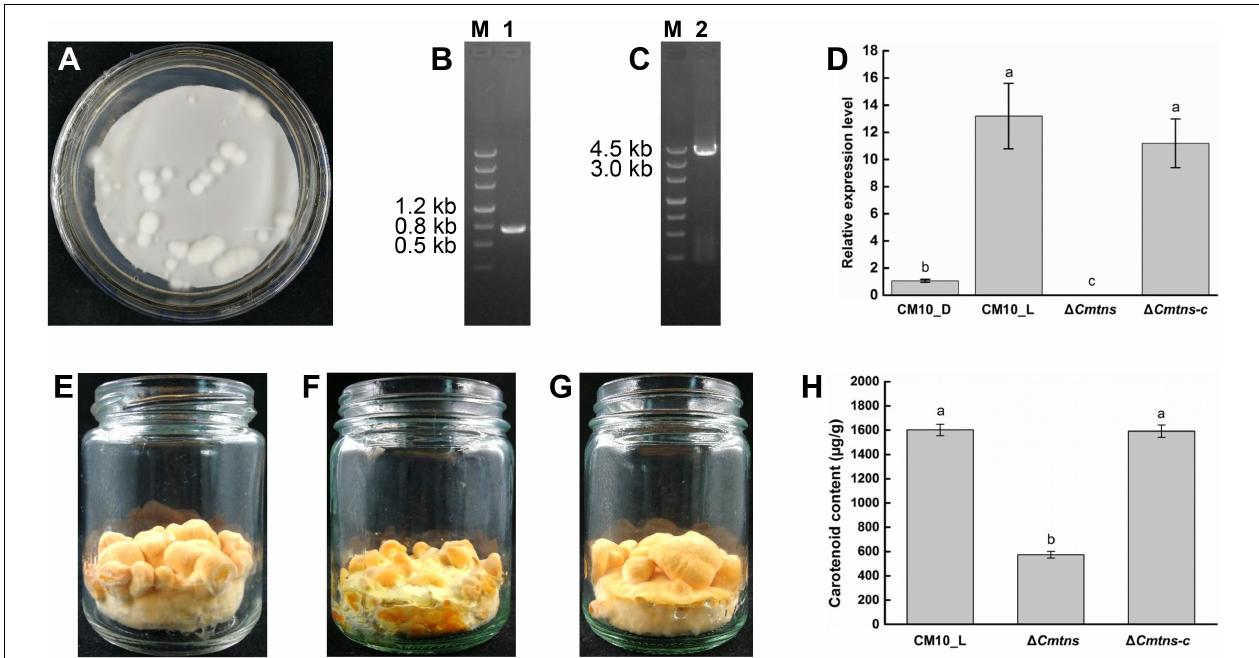
FIGURE 4 | Study on the function of the Cmtns gene. (A) The conidia of the (cid:49) Cmtns mutant were co-cultured with the Agrobacterium tumefaciens strain AGL1-pCAMBIA0390-Ben-Comtns on PDA medium supplemented with 3 µ g/mL of benomyl, and the co-culture plate for complementation of the Cmtns gene was obtained. (B) PCR amplification of the ben gene in the (cid:49) Cmtns-c strain. (C) PCR amplification of the Cmtns gene in the (cid:49) Cmtns-c strain. (D) qRT-PCR analysis of the Cmtns gene expression. (E) C. militaris CM10 cultured on rice medium. (F) C. militaris (cid:49) Cmtns cultured on rice medium. (G) C. militaris (cid:49) Cmtns-c cultured on rice medium. (H) Analysis of carotenoid content in C. militaris . Data are means ± standard error from three independent experiments. Different letters (a–c) above the bars indicated significant difference (ANOVA followed by Duncan’s multiple-range tests, P <